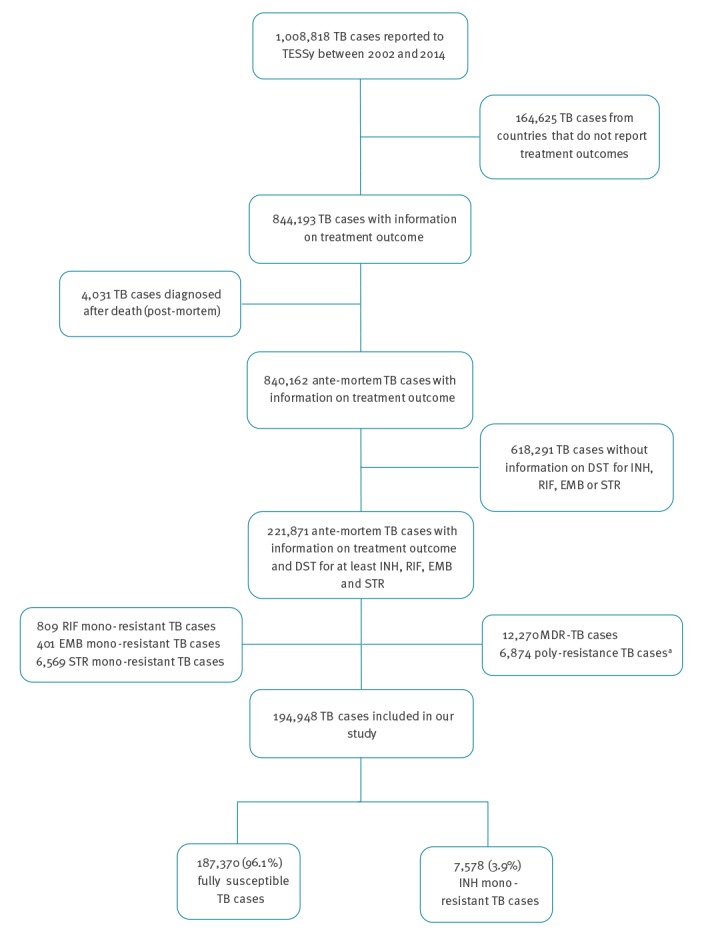
Flow chart of cases included in analysis of treatment outcome of isoniazid mono-resistant tuberculosis, 31 EU/EEA countries, 2002–2014